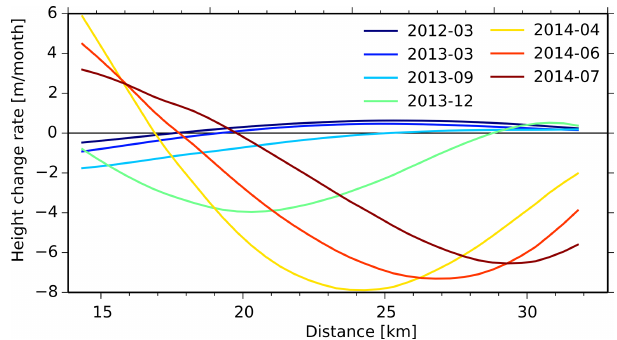
Figure 14. Dynamically caused ice-height changes derived from velocity profiles along a flow line (as marked in Fig. 5). The distance is measured from the 1916 glacier front